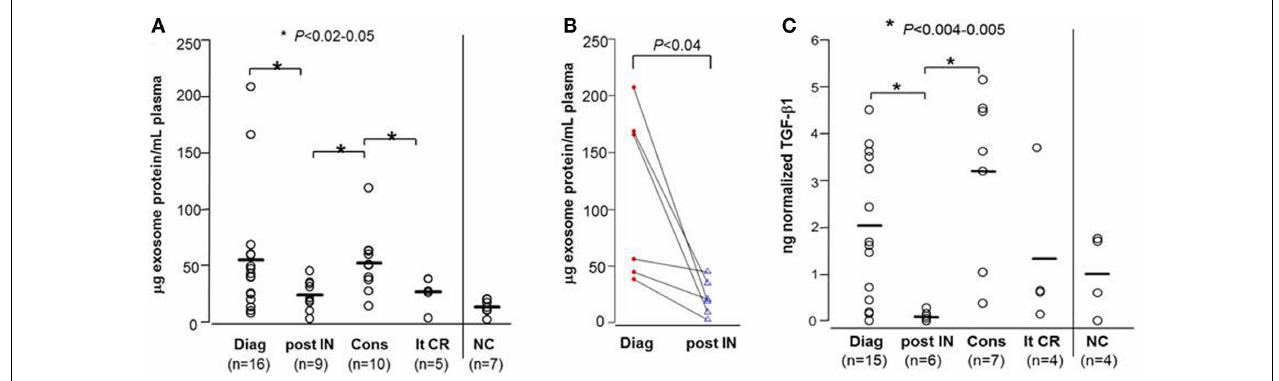
obtained from the same patients at AML diagnosis and 14days after starting induction CT. (C) ExosomalTGF- β 1 levels measured by ELISA after exosome sonication/acidification for patients in different cohorts. In this and all subsequent figures,TGF- β 1 values were normalized per microgram exosomal protein in 1mL plasma.The bars indicate mean levels.